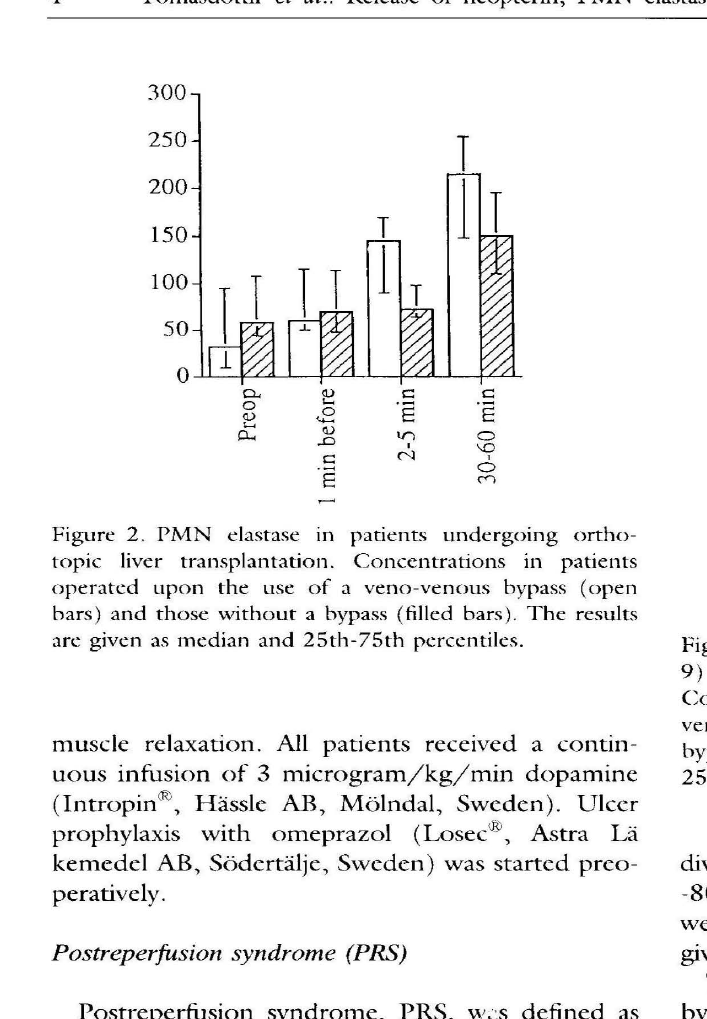
kemedel AB, Sodertalje, Sweden) was started preo peratively.